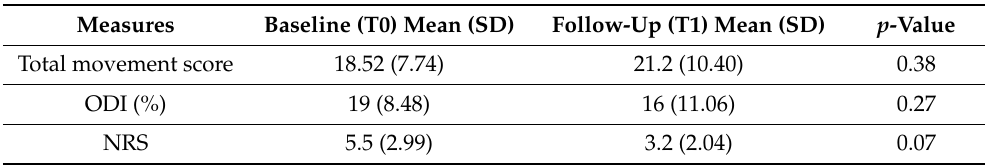
Table 6. Average results (T0 vs. T1) of patients with cLBP differences that were tested with the Wilcoxon sign rank